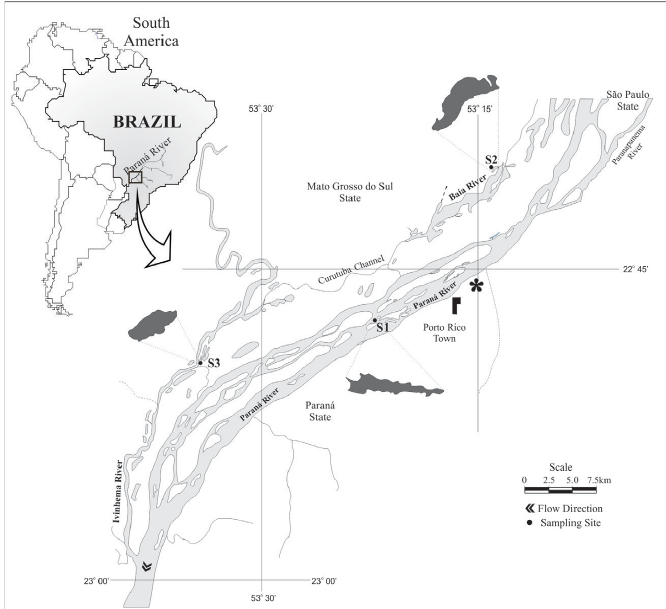
Figure 1. Map and location of sampling sites in the upper Paraná River floodplain. S1, lake related to the dammed river (Paraná River); S2 and S3, lakes related to the non-dammed rivers ( Baia and Ivinhema River).